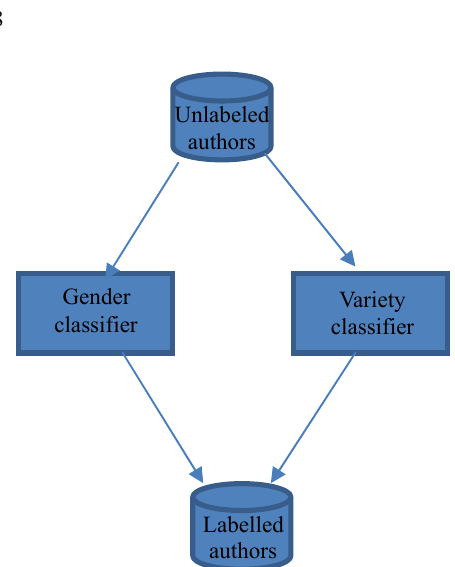
Fig 4: Graphical Illustration of Loose Classification [47]